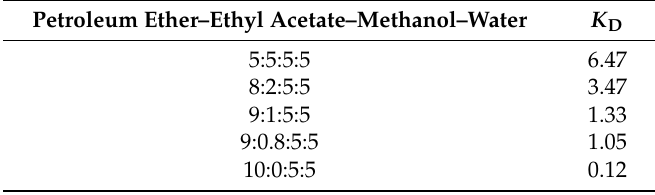
Table 5. The distribution constants ( K D ) of the target compounds at different ratios of volume in petroleum ether-ethyl